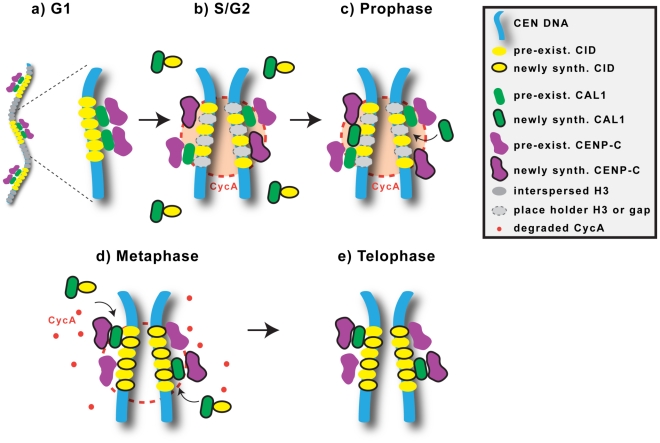
Model for centromere assembly in Drosophila cells.During the G1 phase of the cell cycle, the centromere contains the constitutive proteins CID, CENP-C and CAL1, which are reciprocally required for localization and interact physically. Blocks of CID nucleosomes (yellow) are interspersed with blocks of H3 nucleosomes (grey; not shown in zoom and subsequent phases for simplicity). Soluble CID is associated with CAL1. B) In S phase, centromeric DNA is replicated and, as a result, CID, CENP-C and CAL1 become diluted. Histone H3 may be deposited temporarily within CID blocks as a placeholder. Newly-synthesized CENP-C as well as pre-existing, soluble, CENP-C (not shown) are recruited to centromeres in interphase and mitosis (not shown). C) During prophase, free newly-synthesized CAL1 is deposited at centromeres, replenishing the diluted CAL1. CYCA is localized at centromeres throughout the cell cycle, and could prevent deposition of new CID until metaphase. D) During metaphase, CYCA is degraded, an event that promotes incorporation of new CID, pre-existing CAL1 dissociates from the centromere, and newly-synthesized CID is recruited at centromeres possibly by delivery through CAL1. E) In telophase, the levels of CAL1 increase again, by addition of pre-existing CAL1 at the sites left open by its dissociation during metaphase. Reduced levels of total CAL1 in metaphase may be required to ensure that the correct amount of CID is deposited [25].